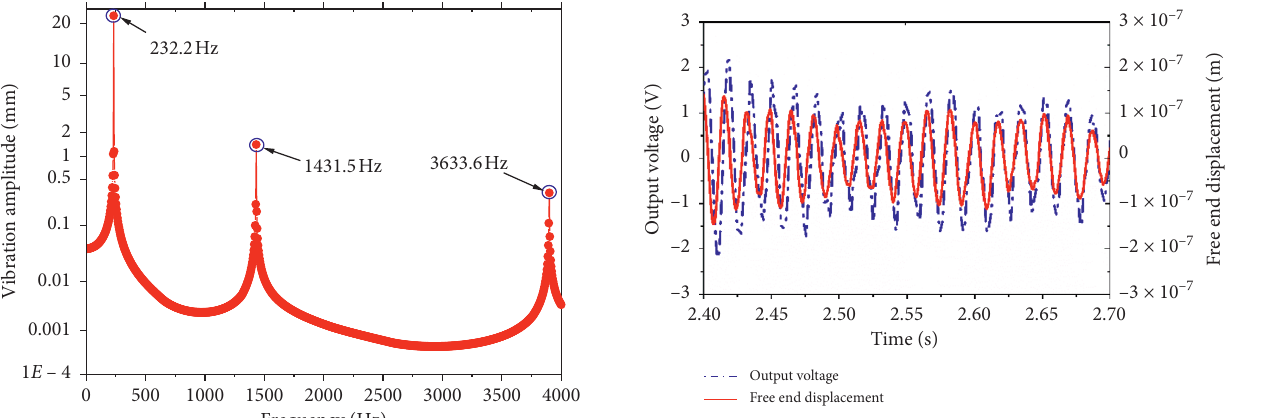
Figure 13: Open-circuit voltage and free end displacement on the piezoelectric cantilever beam ((D) �